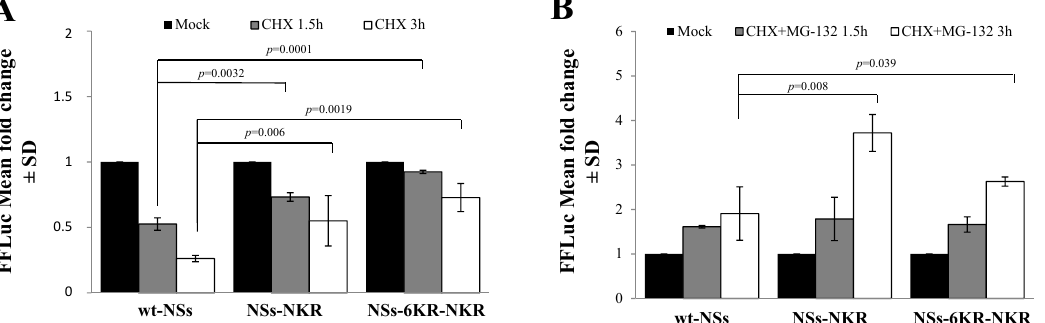
Figure 7. E ff ects of amino-terminal lysine residues on protein stability. ( A ) Lysates of NSs-NKR and NSs-6KR-NKR-transfected cells were collected at di ff erent time points after CHX exposure and subjected to the dual-luciferase assay in order to estimate the stability of NSs protein variants by measuring the FFLuc residual activities. ( B ) Cells expressing new NSs mutants, treated with 25 µ M of MG-132, along with 100 µ g / mL of CHX, evidenced the activity of the inhibitor on both NSs-NKR and NSs-6KR-NKR. Cells were collected at 1.5 and 3 h post-treatment and lysates were subjected to a dual-luciferase assay in order to estimate the stability of NSs protein variants. The error bars represent the standard deviation from the mean values obtained in independent experiments ± standard deviations